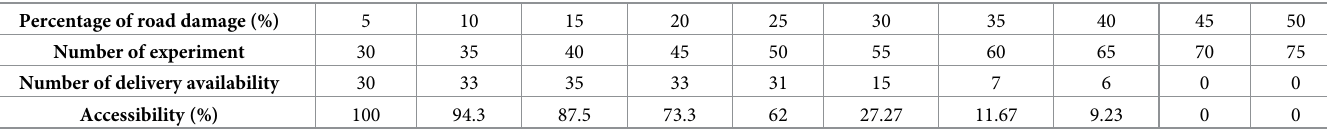
Table 21. Simulation tests of spatial accessibility of